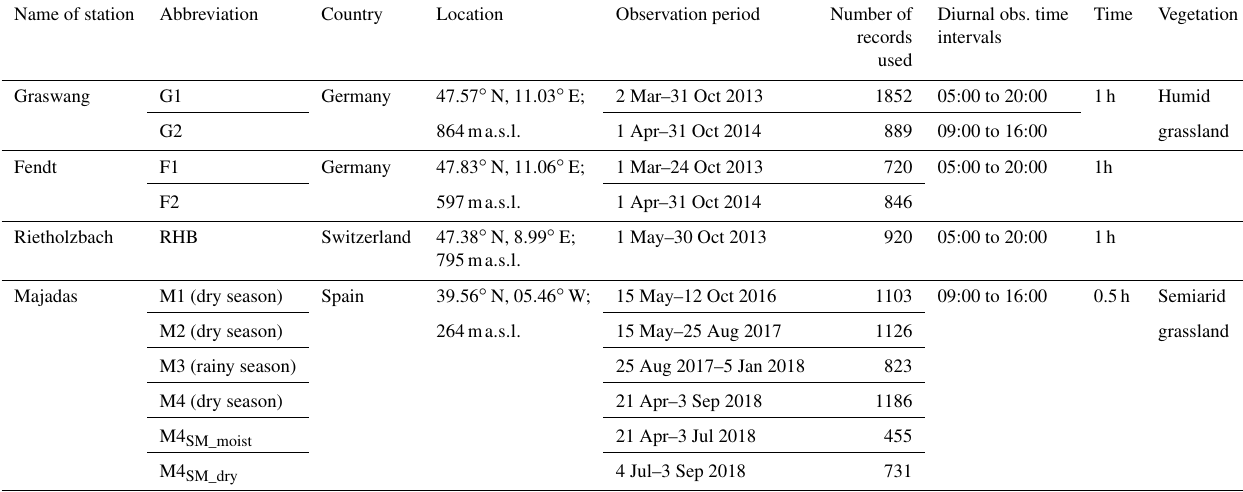
Datawereobtainedfromthefollowinginstitutions:(1)Graswang(G)andFendt(F)fromM.Mauder,InstituteofTechnology(KIT-Karlsruhe),Garmisch-Partenkirchen,Germany;andR.Kiese,Institutefor Technology,InstituteofMeteorologyandClimate,Karlsruhe,Germany;(2)Majadas(M)fromM.MigliavaccaandO.Perez-Priego,MaxPlanckInstituteforBiogeochemistry,Jena,Germany;and(3)Rietholzbach